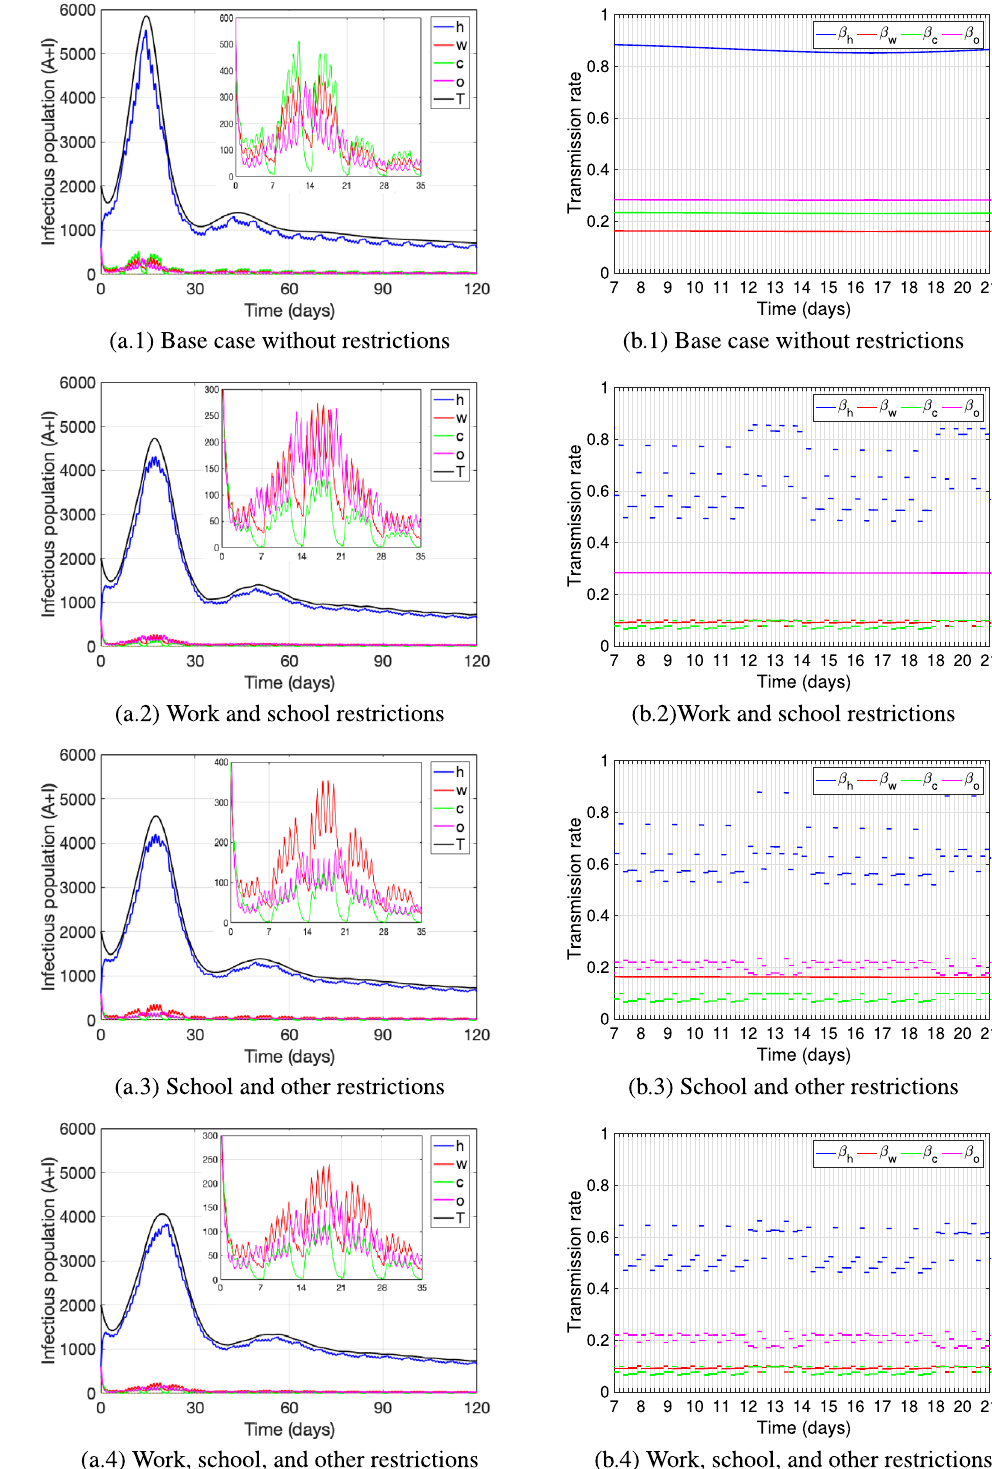
Figure 5. The figures ( a.i ), i = 1–4 depict the number of active cases ( A ( t ) + I ( t ) )- the infectious population- at each location: home ( h , blue), work ( w , red), school ( c , green) and other ( o , pink); as well as the total number of active cases ( T , black). The curves are pictured for a base case without restrictions, and under several restrictions to attend locations applied at once: ( a.1 ) base case, ( a.2 ) work and school, ( a.3 ) school and other, ( a.4 ) work, school and other. For each case, the figures ( b.i ), i= 1 − 4 show the respective transmission rates at each location, pictured for time blocks within each day, from day 7 to day 21. The restrictions are obtained by reducing the parameters α x and α i x , x ∈ { w , c , o } , by: 25% for work, 73% for school, 30% for other activities. The parameter values used are as in Table